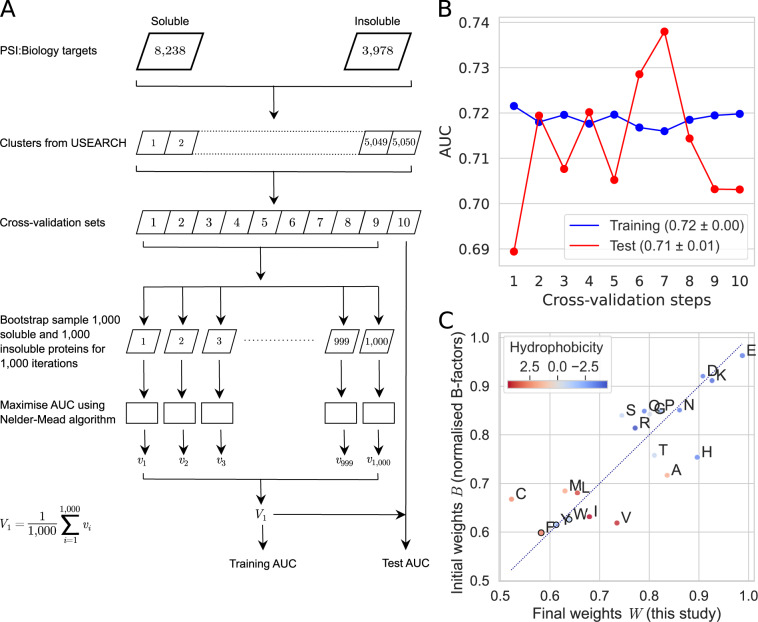
Derivation of the SWI. (A) Flow chart shows an iterative refinement of the weights of amino acid residues for solubility prediction. Each cross-validation step used separate sequence similarity clusters for training and testing. Furthermore, bootstrapping was used to resample each training set, avoiding training and testing on similar sequences. The solubility scores of protein sequences were calculated using a sequence composition scoring approach. These scores were used to compute the AUC scores for training and test datasets. (B) Training and test performance of solubility prediction using optimized weights for 20 amino acid residues in a 10-fold cross-validation (mean AUC ± standard deviation). Related data and figures are available as Supplementary Table S3 and Figures S4 and S5. (C) Comparison between the 20 initial and final weights for amino acid residues. The final weights W=〈Vi〉, 1≤i≤10 were used to calculate the solubility score of a protein sequence (SWI) in the four subsequent analyses. Filled circles, which represent amino acid residues, are colored by hydrophobicity (Kyte and Doolittle, 1982). Solid black circles denote aromatic residues phenylalanine (F), tyrosine (Y), tryptophan (W). Dotted diagonal line represents no change in weight. See also Supplementary Table S4. AUC, Area Under the ROC Curve; ROC, Receiver Operating Characteristic. (Color version of this figure is available at Bioinformatics online.)